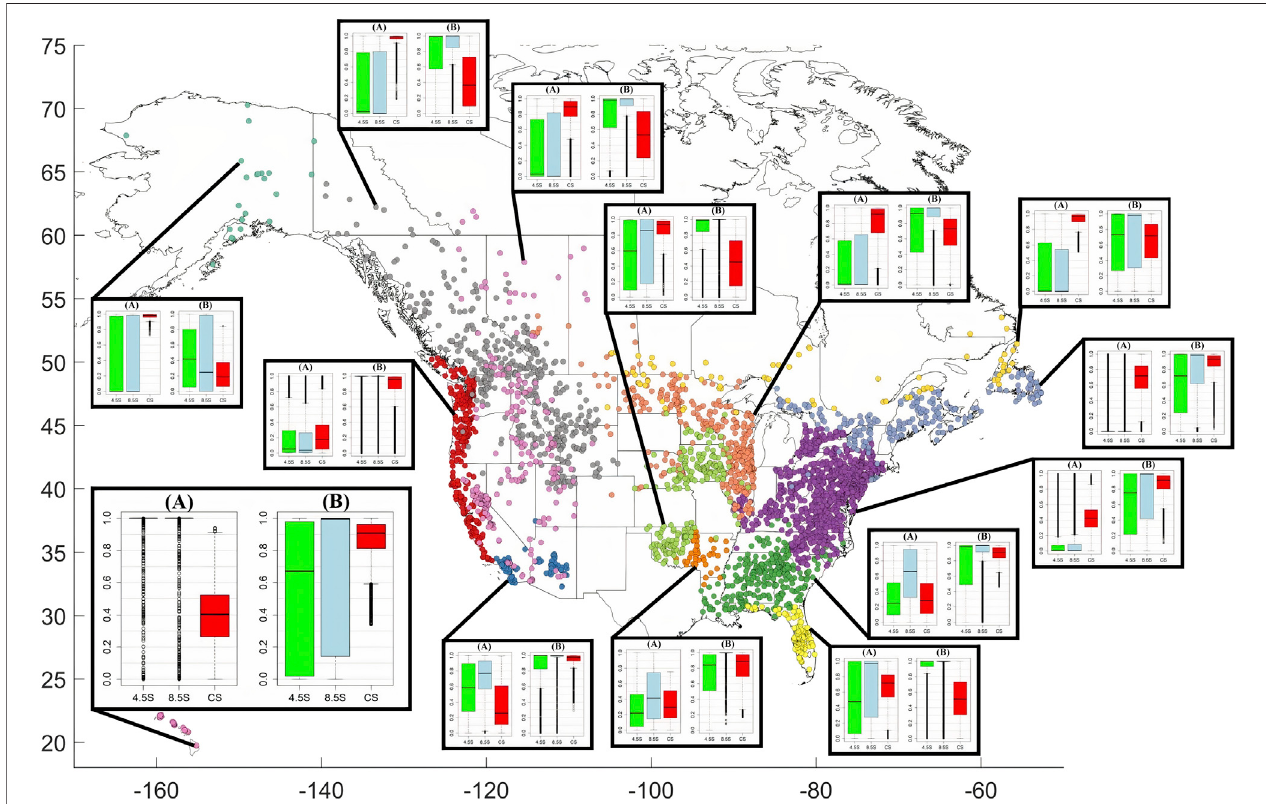
FIGURE 6 | Boxplots of water-supply components of the risk score (equation 3) for each subregion in winter (A) and summer (B) . The left panel for each region includes: the probability of an increase in stream fl ow in winter given the RCP4.5 (RCP8.5) emission scenario, and one minus the present (1993 – 2012) winter freshwater supply,normalizedtobebetween0and1(CS).Therightpanelforeachregionshowsthesamecomponentsoftheriskscore,butforsummer.Thethickblacklinesofthe boxplots indicate the median value while the box shows the range between the fi rst and third quantiles. The points outside the range of the whiskers can be consideredasoutliers.Theclustersare:1)WestCoast,2)Southwest,3)DeepSouth,4)Mid-Atlantic,5)South-CentralUS,6)Florida,7)Hawaii,8)Rockies,9)Alaska,10) Midwest, 11) Northeast, 12) West, 13) Central US, 14) Eastern